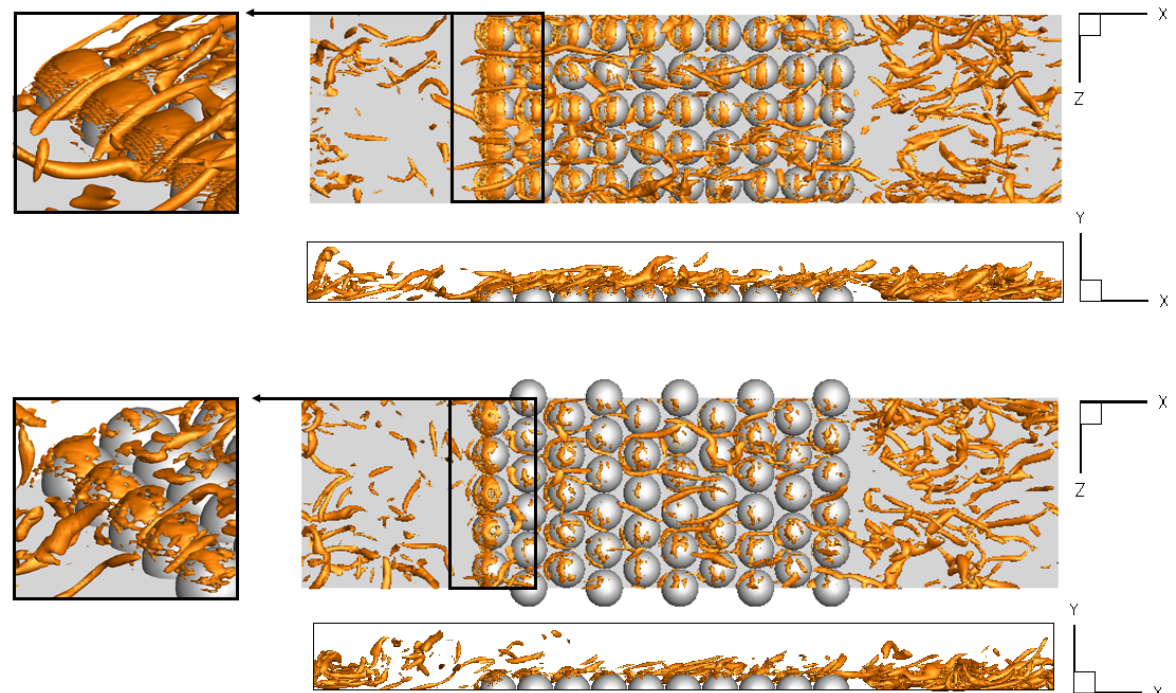
Figure 5. Q-parameter iso-surface in the configurations S2.0o ( upper figures ) and S2.0s ( lower figures ).